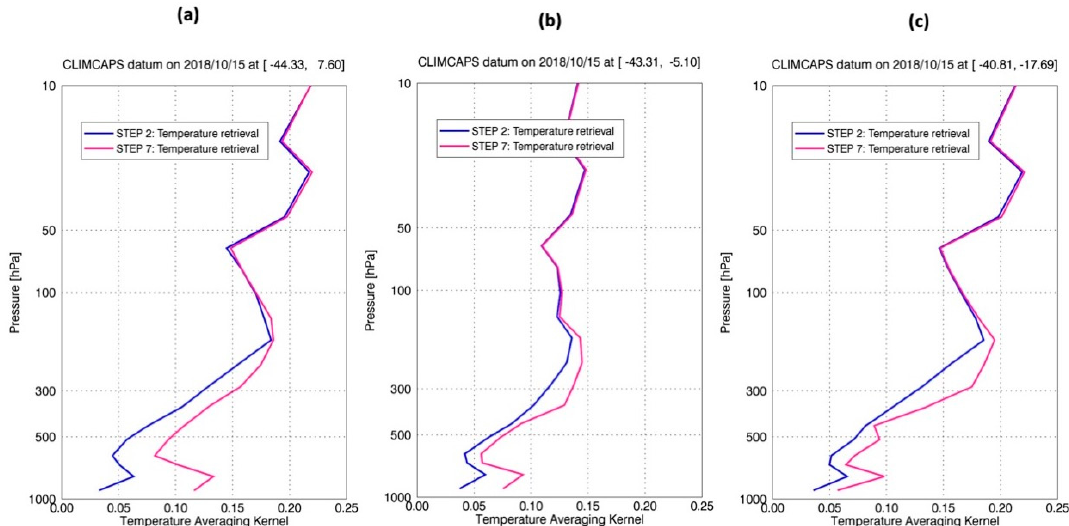
Figure 6. CLIMCAPS averaging kernels for temperature from three individual datums centered on the [latitude, longitude] location in the title at 01h30 on 15 October 2018. CLIMCAPS retrieves temperature twice, once after cloud clearing (blue) and a second time after the retrieval of atmospheric gases (magenta)—H 2 O, CO, O 3 , and HNO 3 . “Step 2” and “Step 7” refer to the steps outlined in Section 2.2.2, Figure 1. The CLIMCAPS sequential retrieval approach allows scene-dependent error propagation to stabilize inversion and maximize information content.